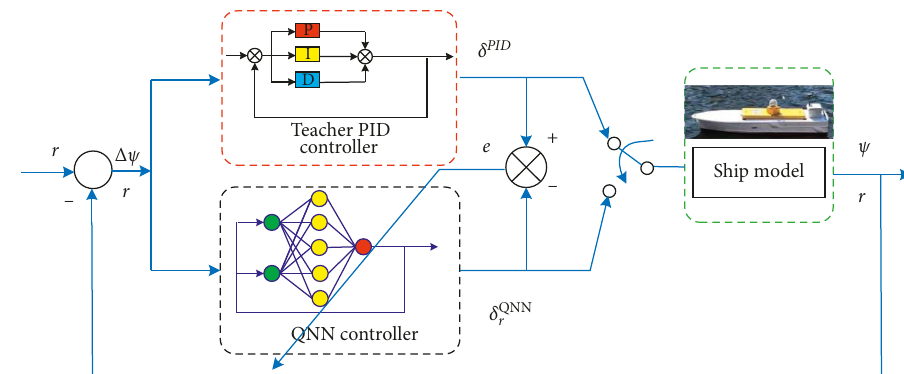
Figure 4: IASV QNN-steering autopilot structure.